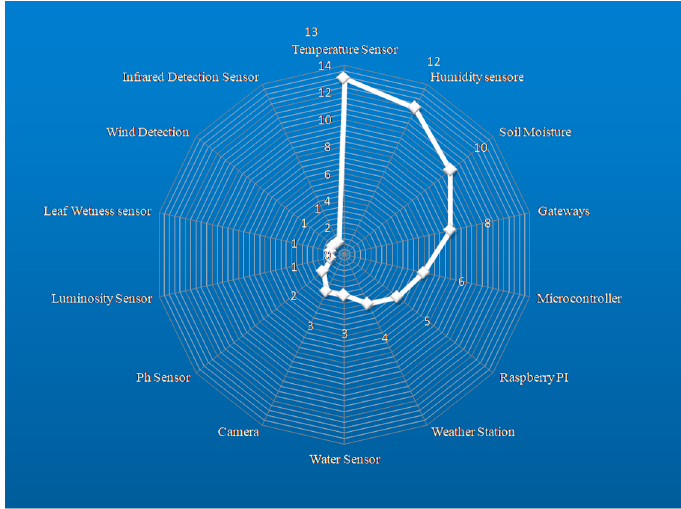
Figure 6. Sensors/devices distribution. Figure 6. Sensors / devices distribution. Table 7. Sensor/devices operation.